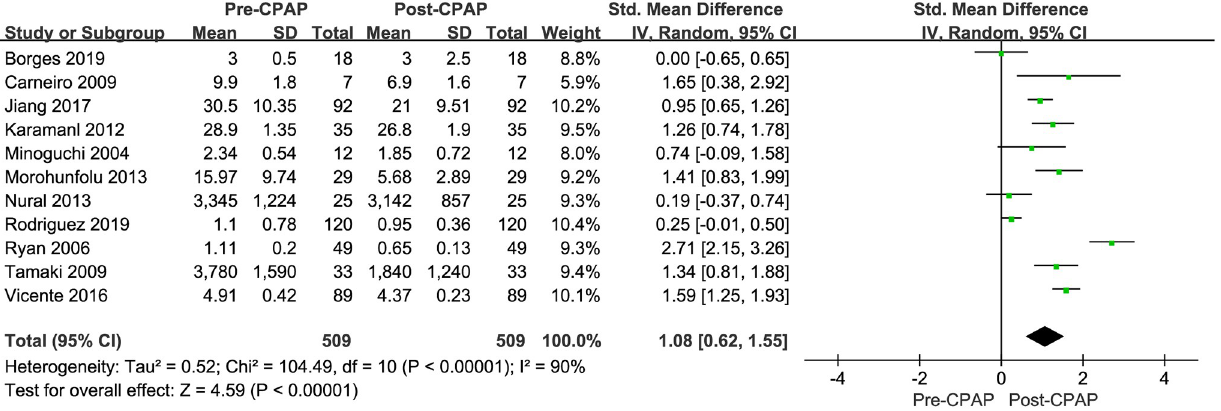
Fig 2. The forest plot outcome indicated that the CPAP therapy will not change the TNF- α level in OSAHS